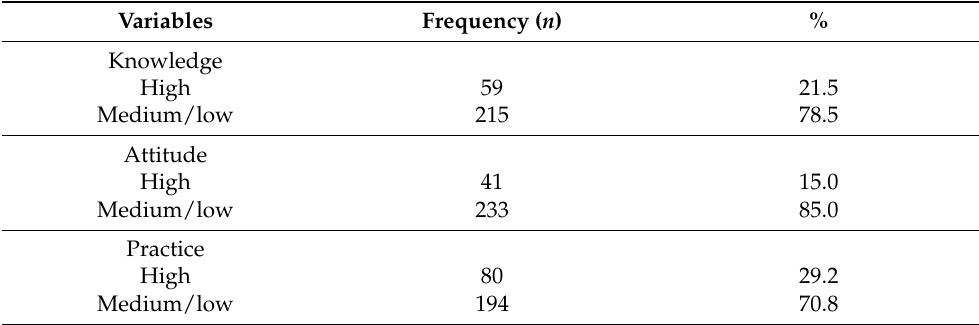
Table 2. Knowledge, attitude, and practice scores of participants regarding diabetic retinopathy (DR) ( n = 274).